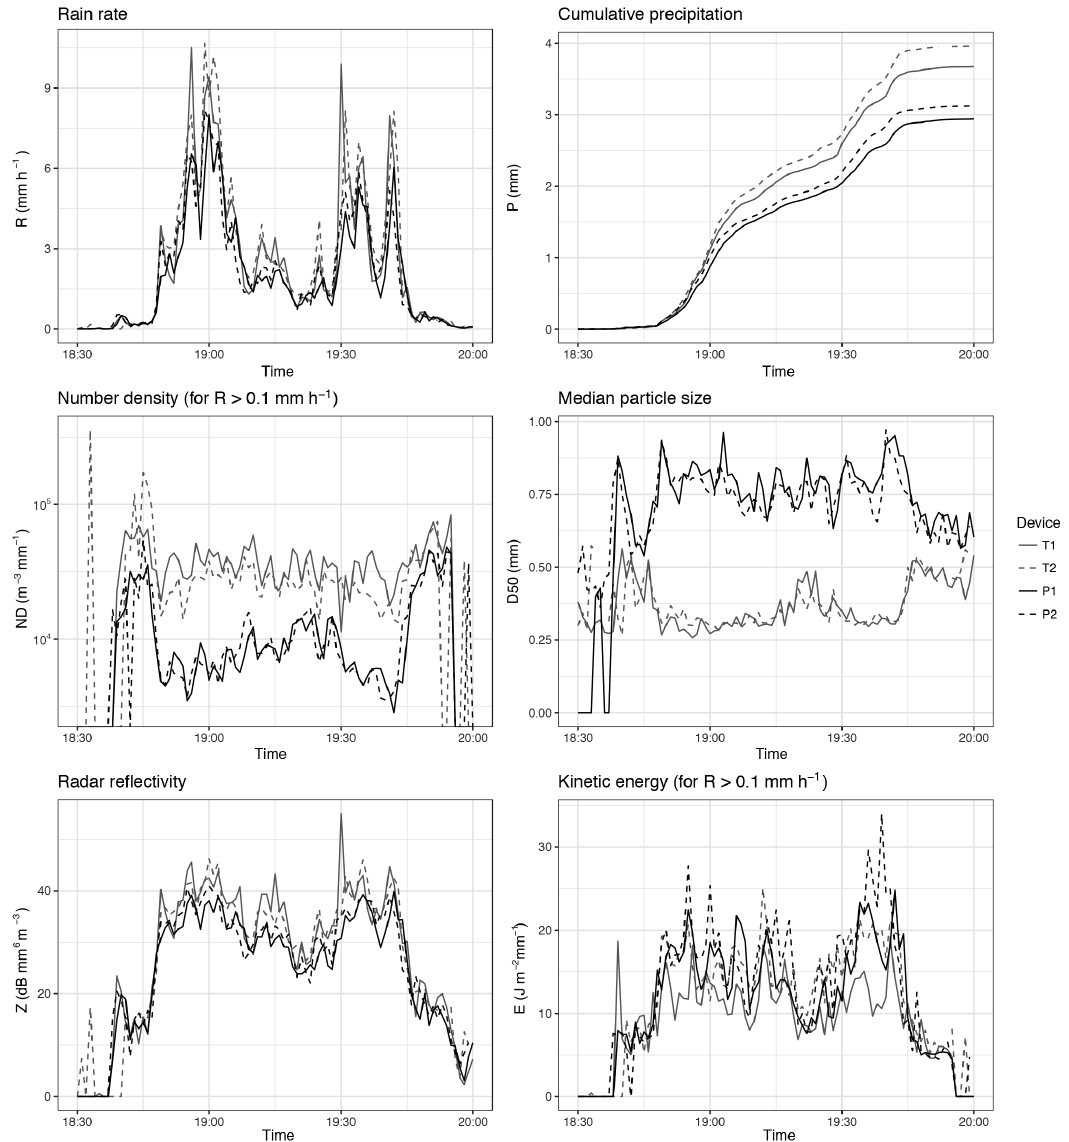
Figure A2. Time series of disdrometer bulk variables during a low-intensity event (E455), with no corrections of the PSVD data.